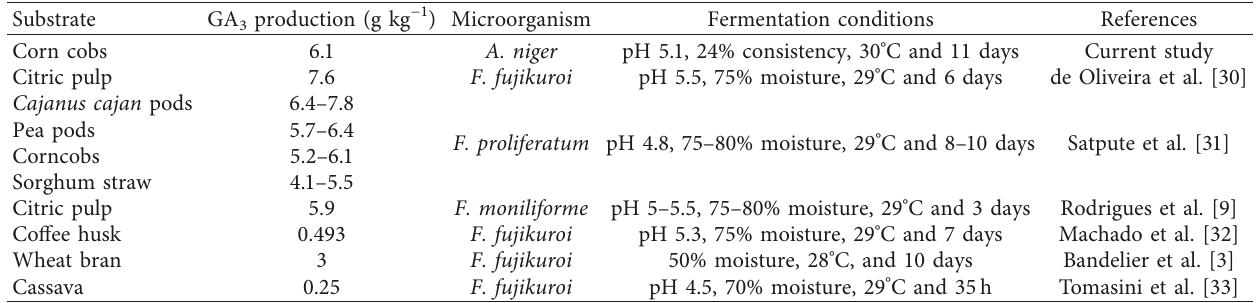
Table 4: GA3 production via SSF using different by-products and